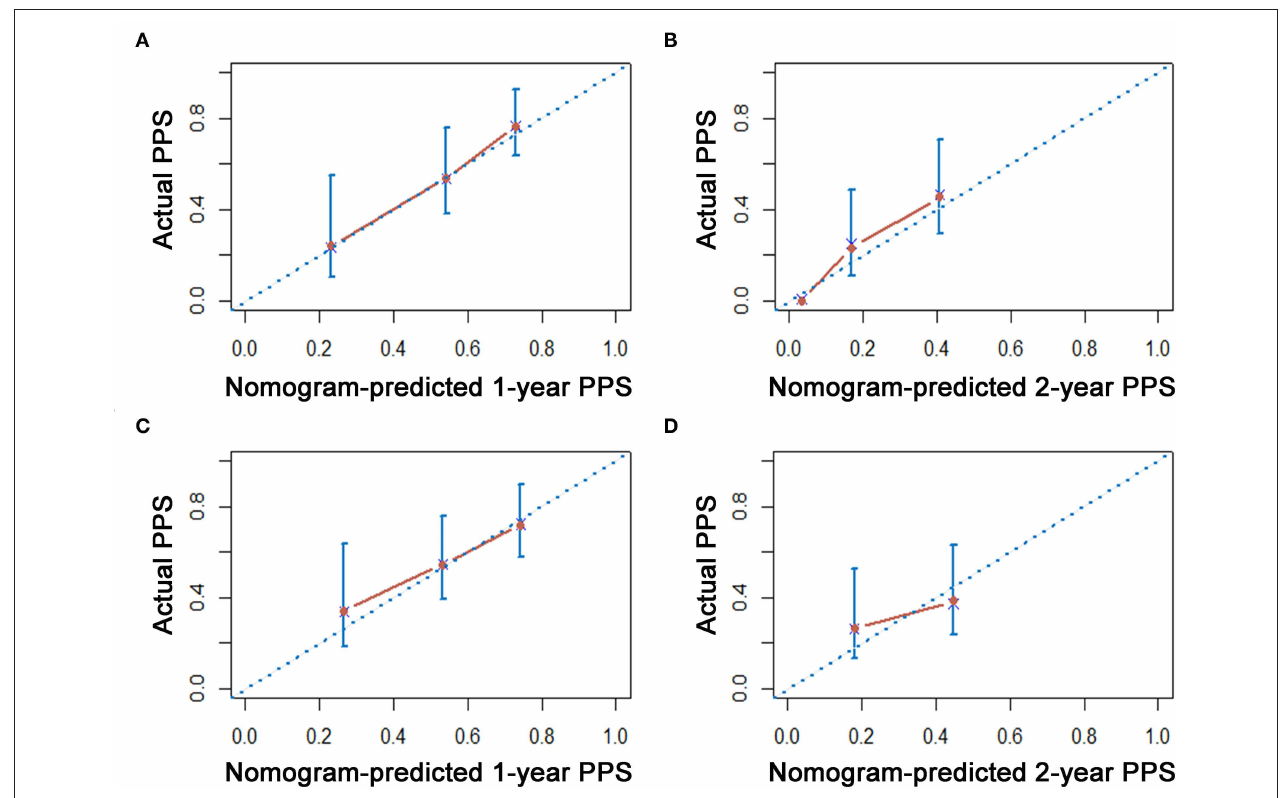
FIGURE 4 | The calibration curve for predicting patient survival at 1 year and 2 years in the training cohort (A,B) and validation cohorts (C,D) , respectively.